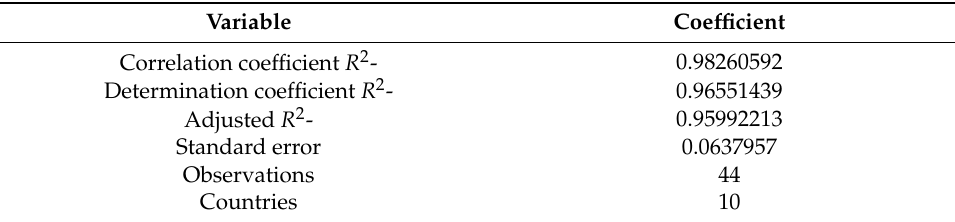
Table 6. Regression of ffCO 2 emissions and